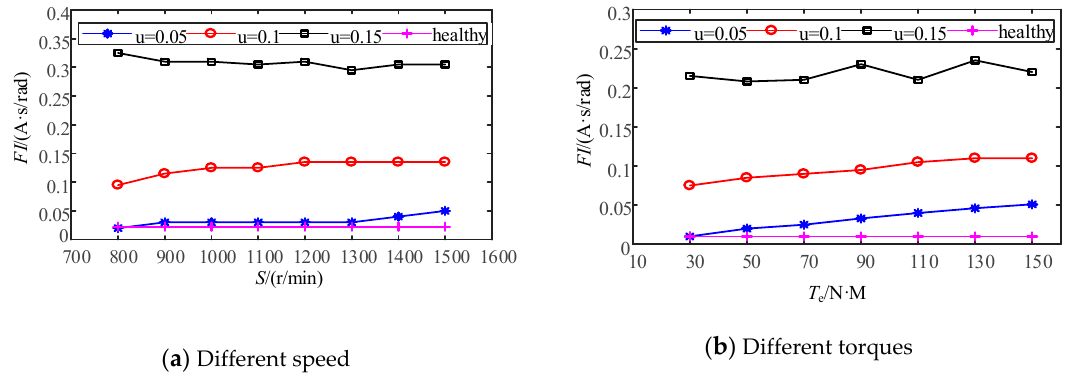
Figure 7. Fault indicators for different working conditions.